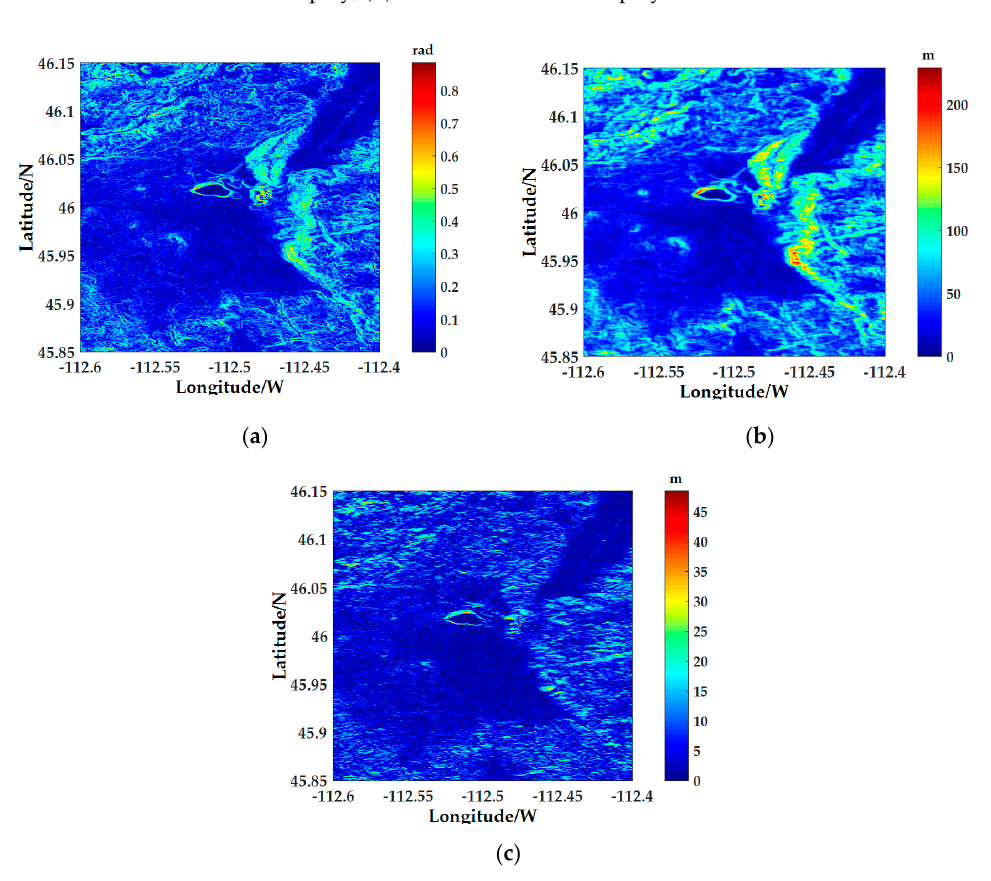
Figure 6. Topographic factors of the simulation area: ( a ) The slope of the simulation area; ( b ) The terrain relief of the simulation area; ( c ) The surface roughness of the simulation area.